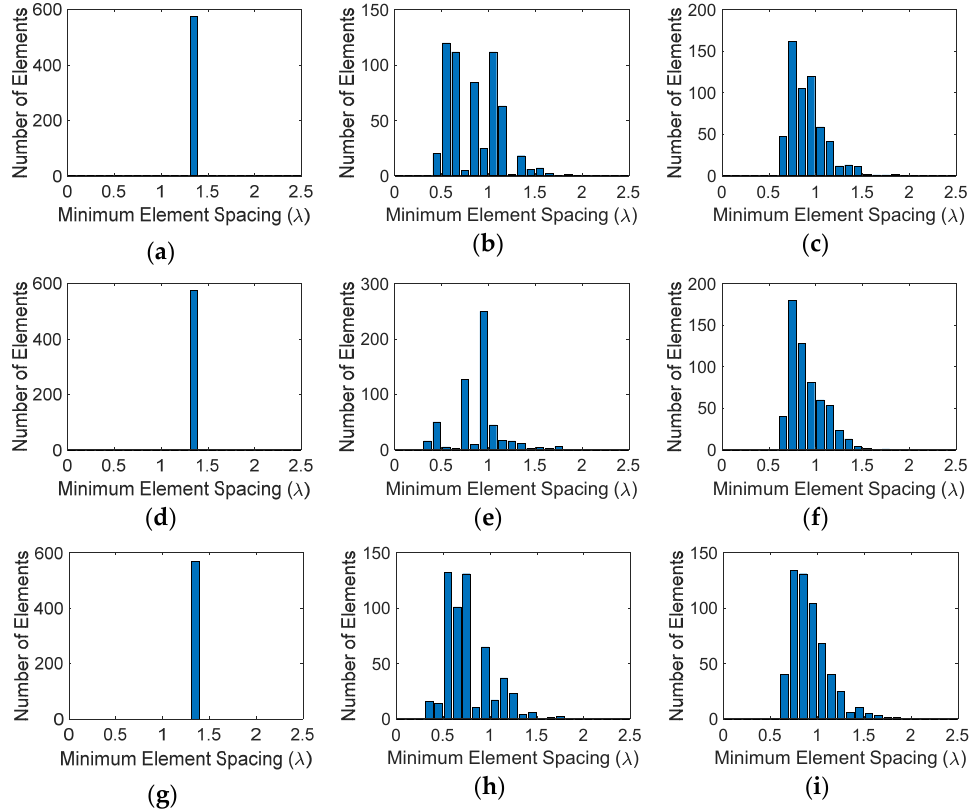
Figure 7. Bar plot of minimum element spacings on rectangular, circular, and elliptical apertures with different distributions: ( a ) uniform (rectangular), ( b ) Halton (rectangular), ( c ) Poisson disk (rectangular), ( d ) uniform (circular), ( e ) Halton (circular), ( f ) Poisson disk (circular), ( g ) uniform (elliptical), ( h ) Halton (elliptical), ( i ) Poisson disk (elliptical).